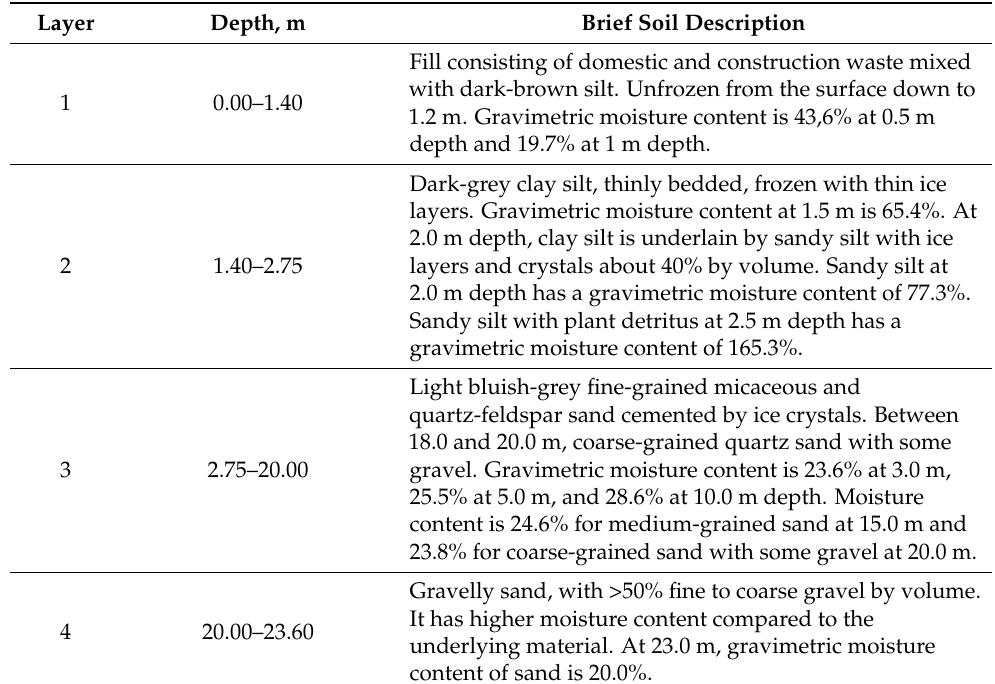
Table 7. Subsurface conditions derived from borehole